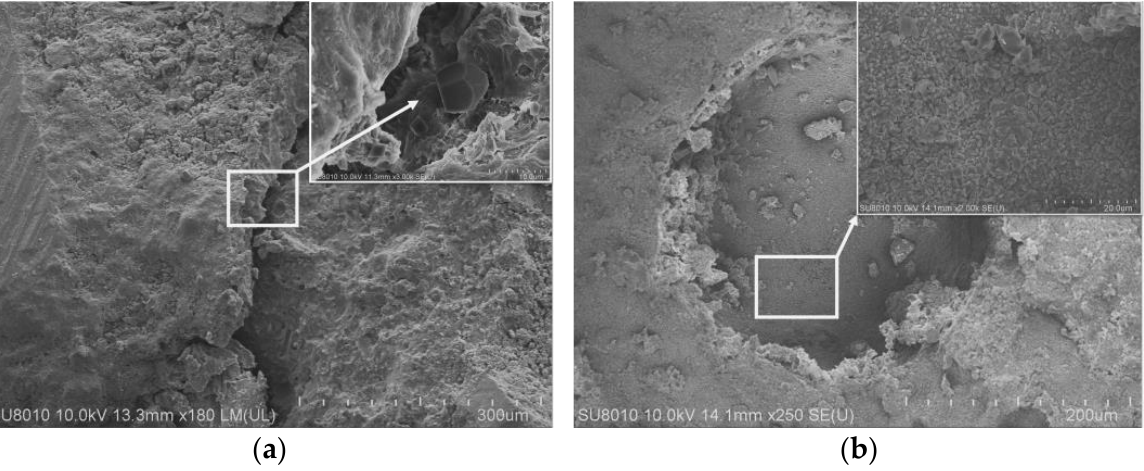
Figure 4. SEM image of joining EVA. ( a ) is the “ micro-crack morphology ” ; ( b ) is the “ internal morphology of the hole ” .